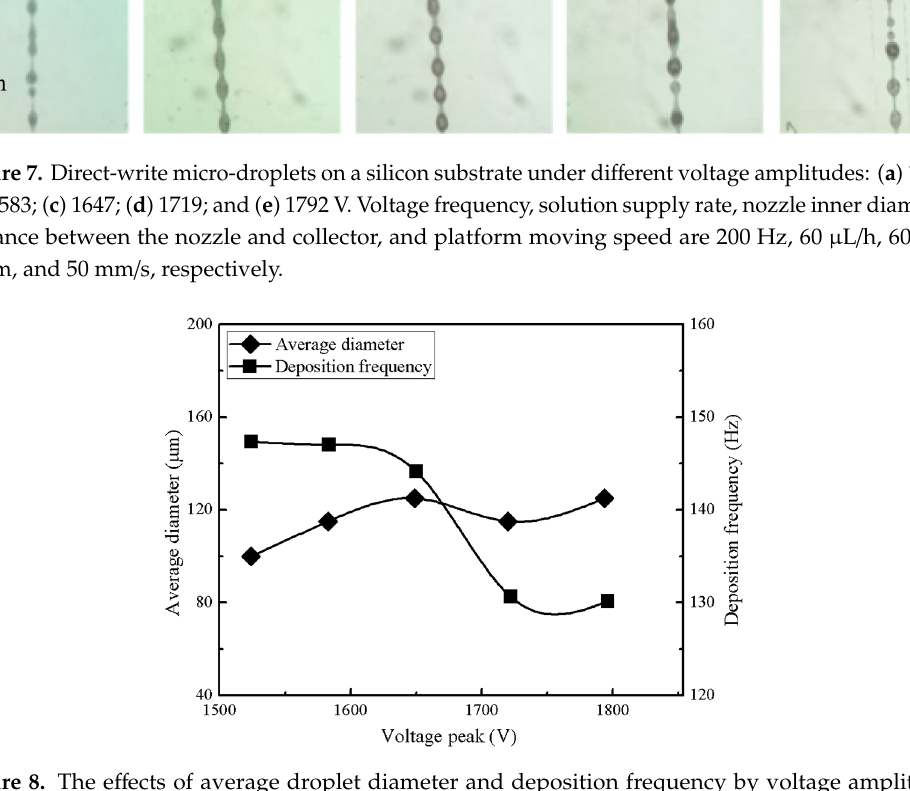
Figure 8. The effects of average droplet diameter and deposition frequency by voltage amplitude. Voltage frequency, solution supply rate, nozzle inner diameter, distance between nozzle and collector, and platform moving speed are 200 Hz, 60 μL/h, 60 μm, 3 mm, and 50 mm/s, respectively.